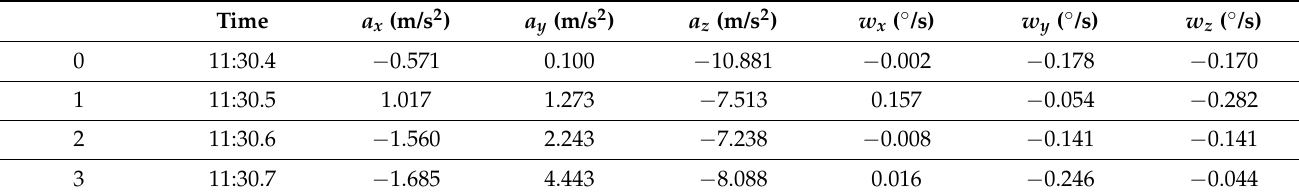
Table 3. IMU data output.